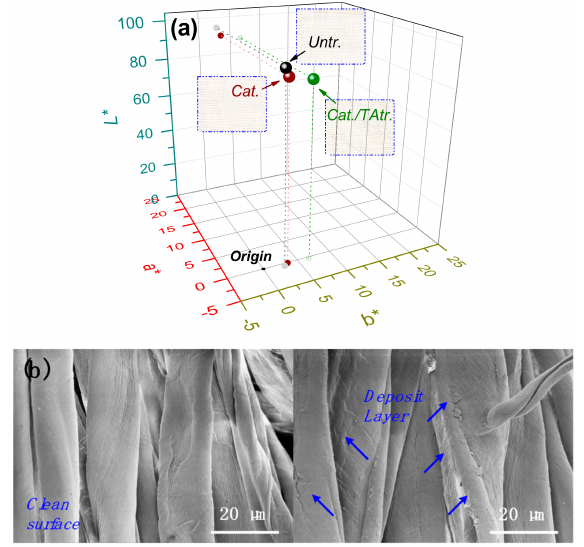
Figure 7. Colour features of Untr., Cat., and Cat./TAtr. cotton fabric: ( a ) L*a*b* values in 3D colour space, and ( b ) SEM images of Untr. ( left ) and Cat./TAtr. ( right )